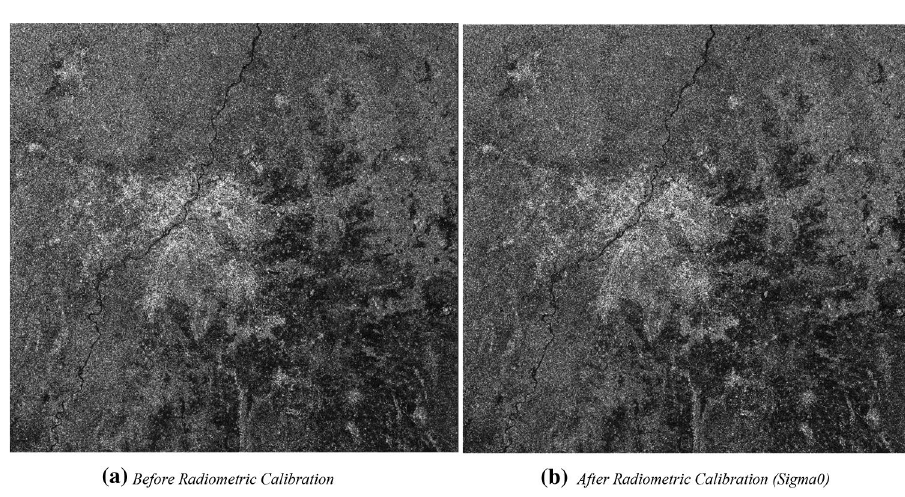
Figure 7. Effect of radiometric calibration in VH